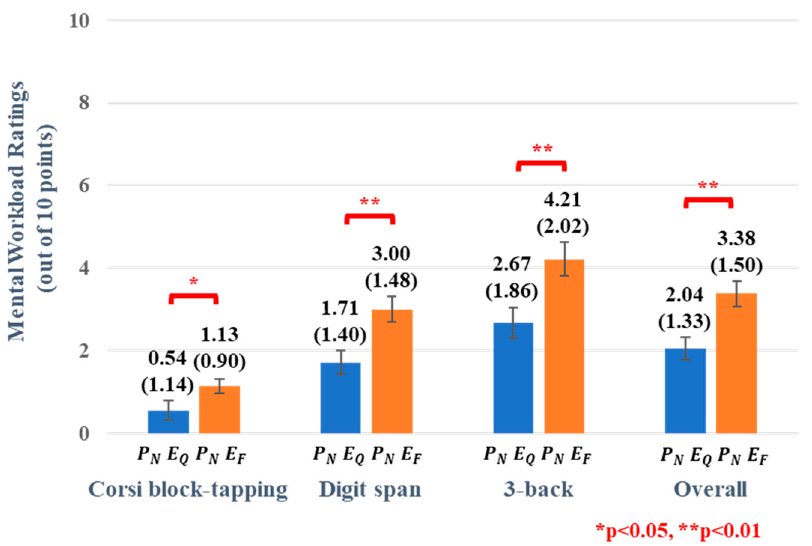
Figure 5. The mean and standard deviation values of task-specific and overall mental workload ratings for each experimental condition.